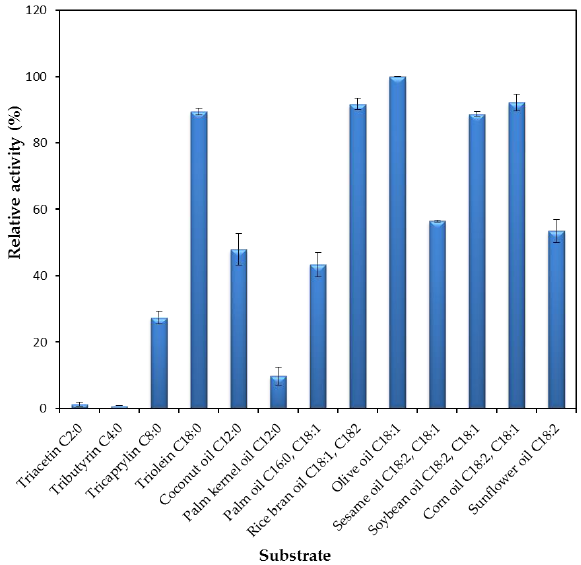
Figure 7. Effect of substrate on the mature rHZ lipase activity. The mature rHZ lipase was assayed with different oil emulsion ( v / v , 1:1) as substrate at 65 °C for 30 min. Data are means ± standard deviations of three determinations ( n = 3) and the standard deviations are indicated as error bars. When the error bar cannot be seen, the deviation is less than the size of the symbol.